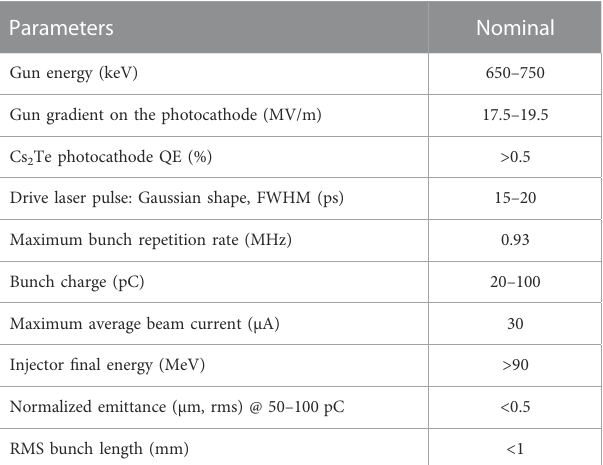
TABLE 1 LCLS-II gun and injector